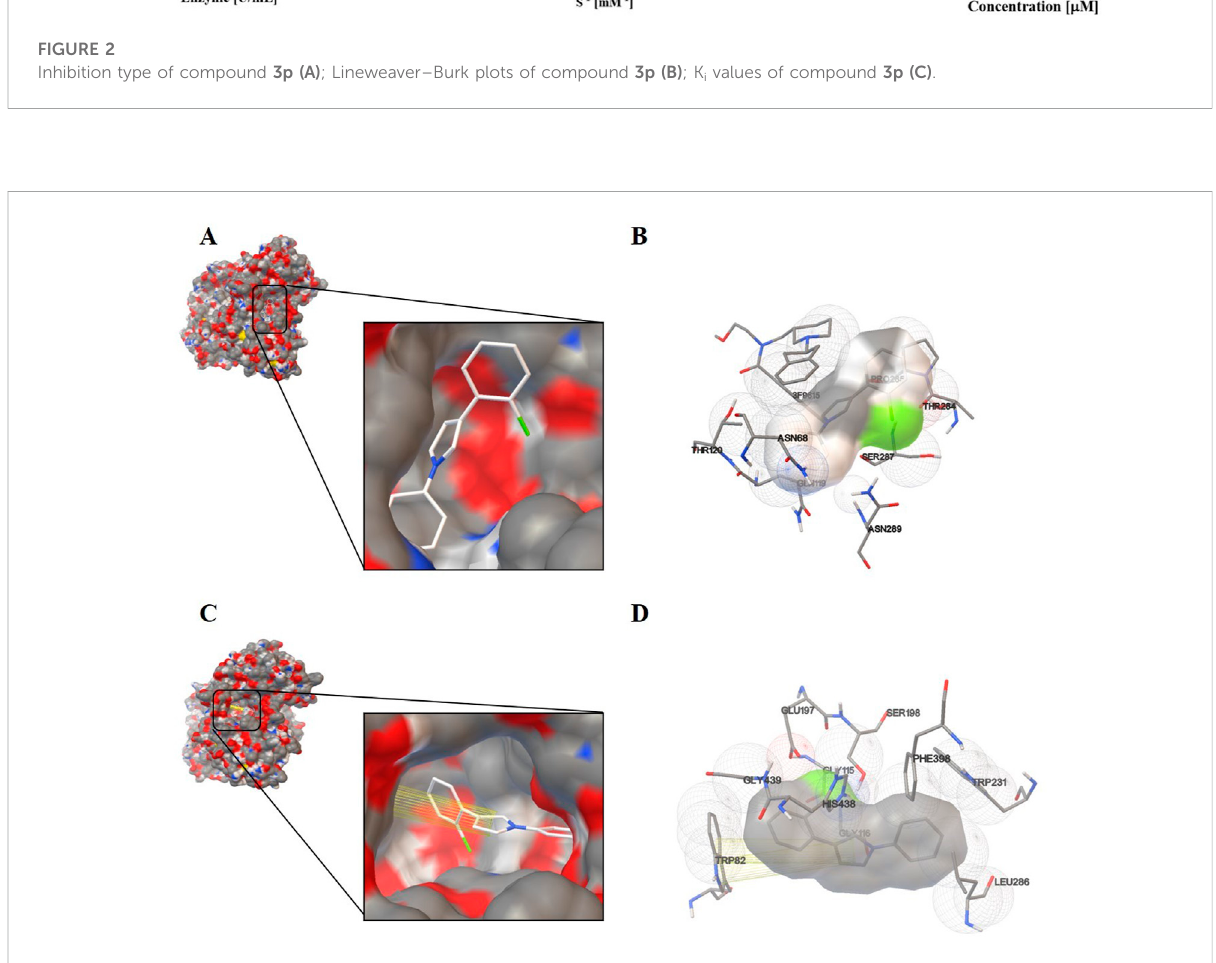
FIGURE 3 Schematicrepresentationfortheproposedbindingmodeofcompound 3p withBChE-3F9615complex(PDBcode:4TPK) (A) orwithBChE (C) . Compound 3p was docked in the active site of BChE in the presence (B) or absence (D) of 3F9615. The co-crystallographic ligand is presented as